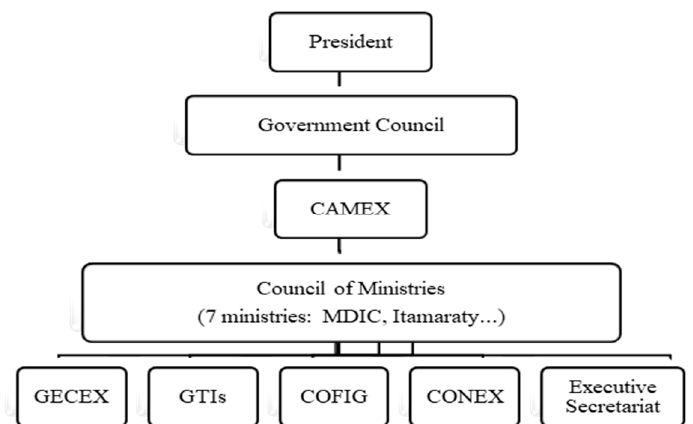
Figure 2. Brazil’s trade policy institutions: Chamber for Foreign Trade (CAMEX) organogram. GECEX—the Executive Management Committee; GTI- The Interministerial Groups; COFIG—the Committee of Financing and Guarantee of Exports; CONEX—the Consultative Council of the Private Sector—CONEX; MDIC—Development, Industry, and External Trade.